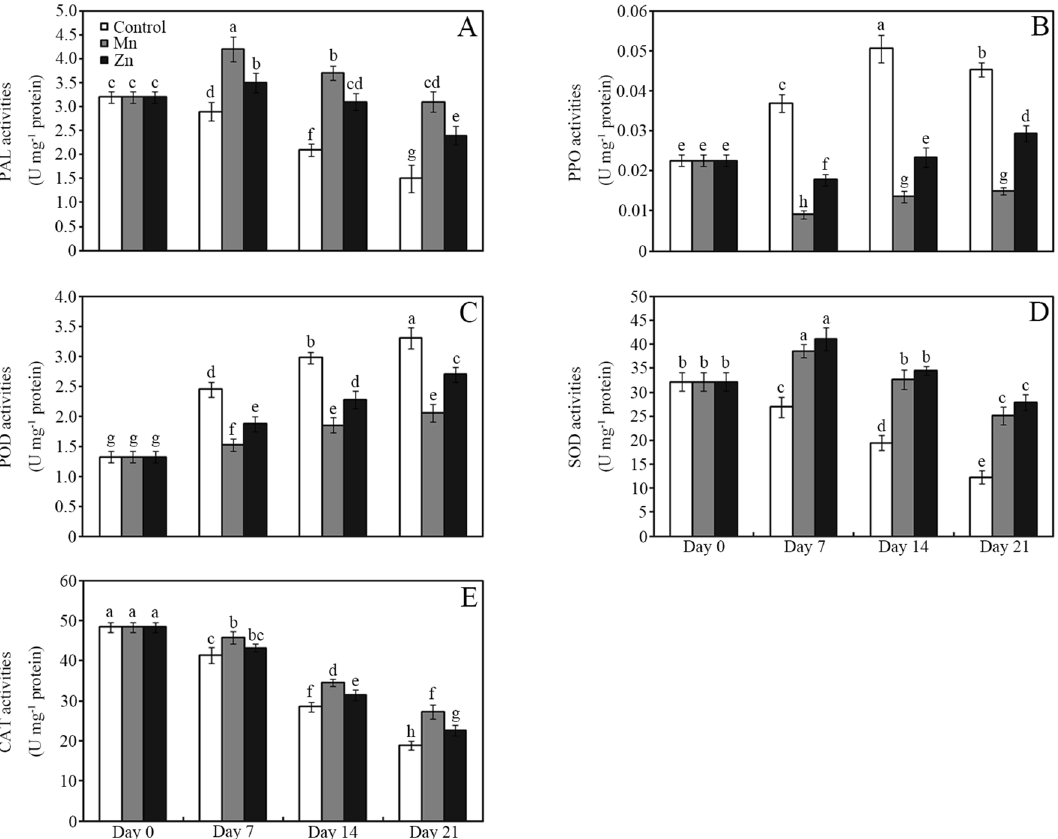
Figure 3. Effects of 10 mM MnCl 2 and ZnCl 2 on PAL ( A ), PPO ( B ), POD ( C ), SOD ( D ) and CAT activities ( E ) of soya bean sprouts after storage for 0, 7, 14 and 21 days. Bars represent the standard deviation of the mean ( n = 3); means associated with the same letter are not significantly different ( P < 0.05). PAL phenylalanine ammonia-lyase, PPO polyphenol oxidase, POD peroxidase, SOD superoxide dismutase, CAT